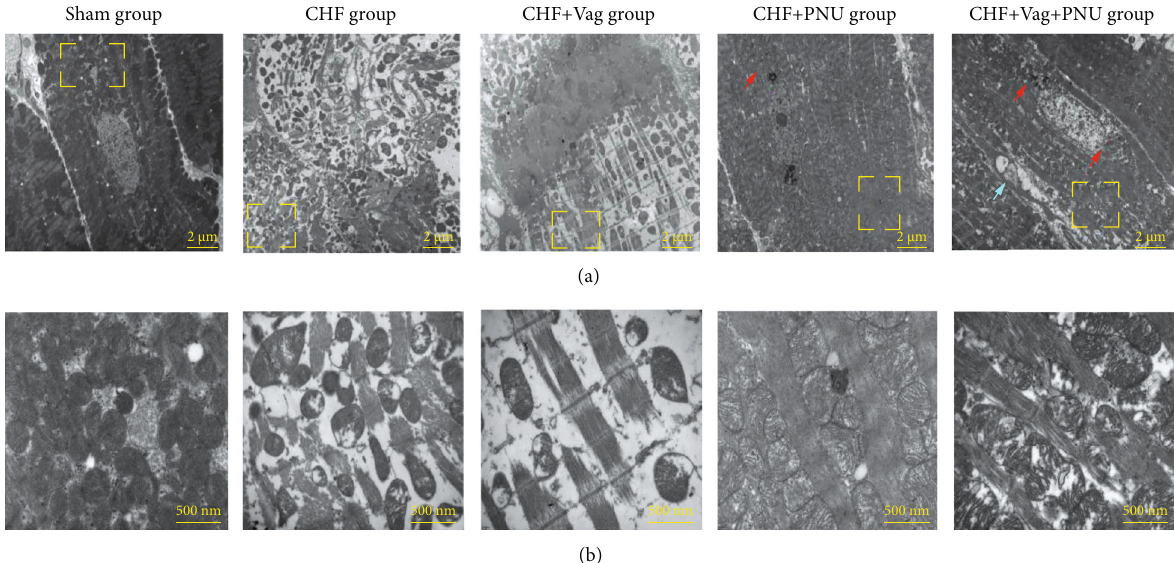
Figure 6: E ff ects of cholinergic elicitation on cardiomyocyte ultrastructural alterations. General observation (a) ( × 5000) and detailed view (b) ( × 30000) of transmission electron microscopy among fi ve groups. Red arrow: mitophagy of autolysosome phase; green arrow: mitophagy of phagophore phase; blue arrow: mitophagy of mitophagolysosome